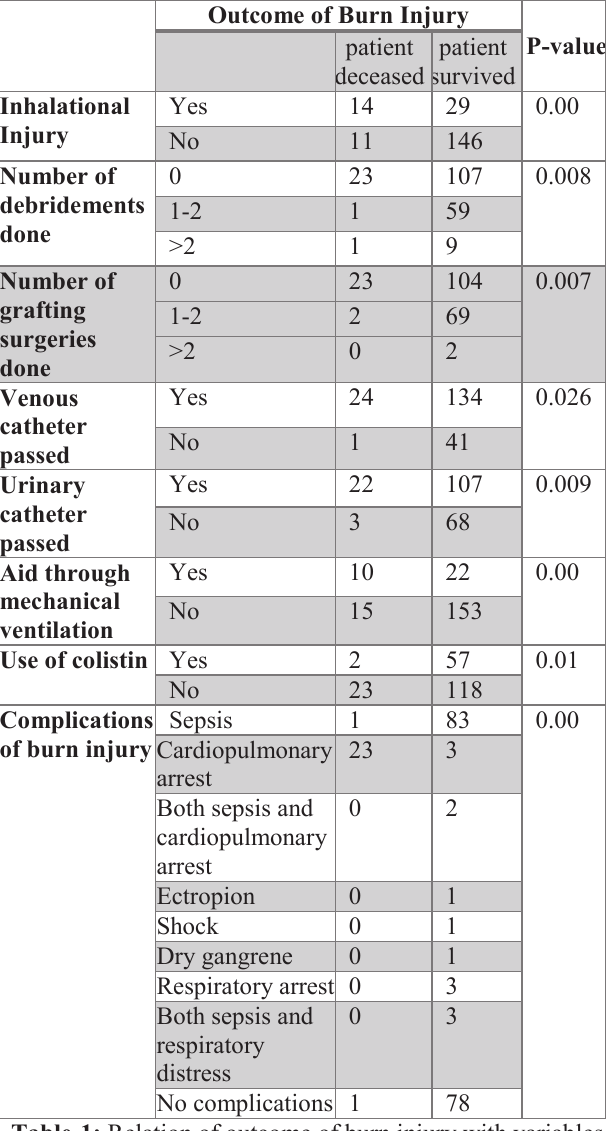
Table-1: Relation of outcome of burn injury with